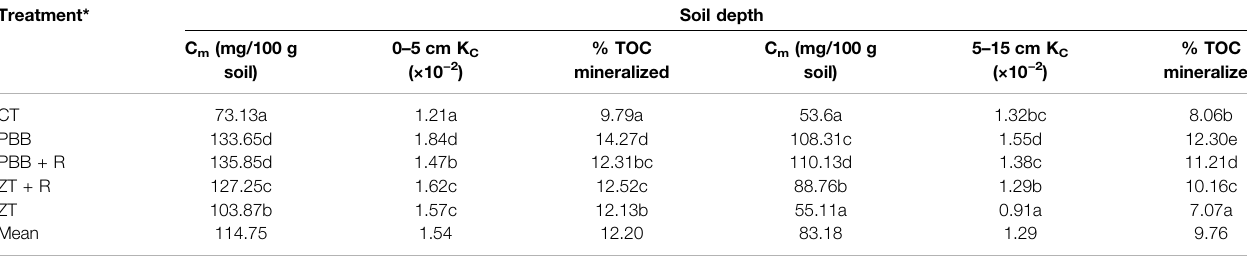
TABLE 4 | Mineralized carbon (Cm) and decomposition constant (Kc) values in 0 – 5 and 5 – 15 cm soil layers. Treatment* Soil depth